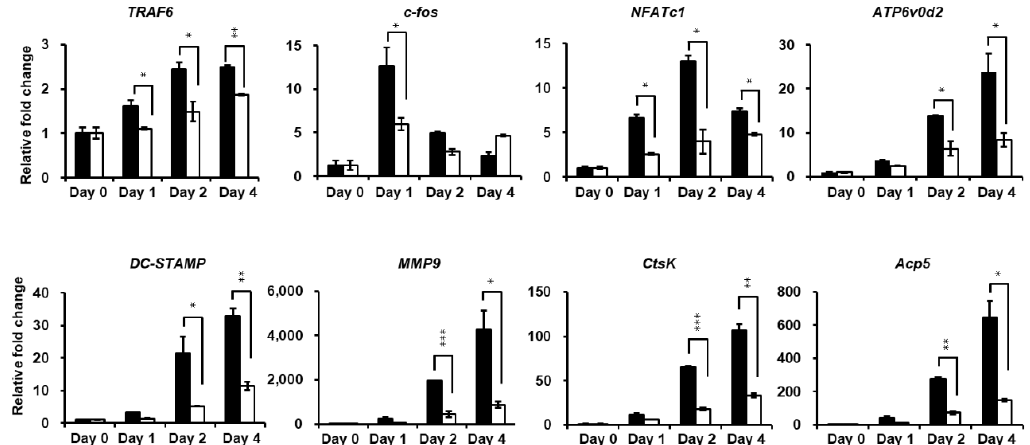
Figure 5. PPOA- N -Ac-2-Cl inhibits RANKL-induced osteoclast-specific gene expression in vitro. Relative mRNA expression of osteoclast-specific genes, TRAF6 , c-fos , NFATc1 , ATP6v0d2 , DC-STAMP , MMP9 , CtsK, and Acp5 (TRAP) , was analyzed by qRT-PCR in the presence or absence of treatment with 6 µM PPOA- N -Ac-2-Cl for 24 h (day 1), 48 h (day 2), or 96 h (day 4). Black bars indicate control, without PPOA- N -Ac-2-Cl treatment, and white bars indicate PPOA- N -Ac-2-Cl-treated group. Transcript levels were normalized to the expression levels of the control at day 0. The primers used for this experiment are listed in Table S1. * p < 0.05, ** p < 0.01, and *** p < 0.001 indicate the statistically significant difference between control and 6 µM PPOA- N -Ac-2-Cl treatment on each day.